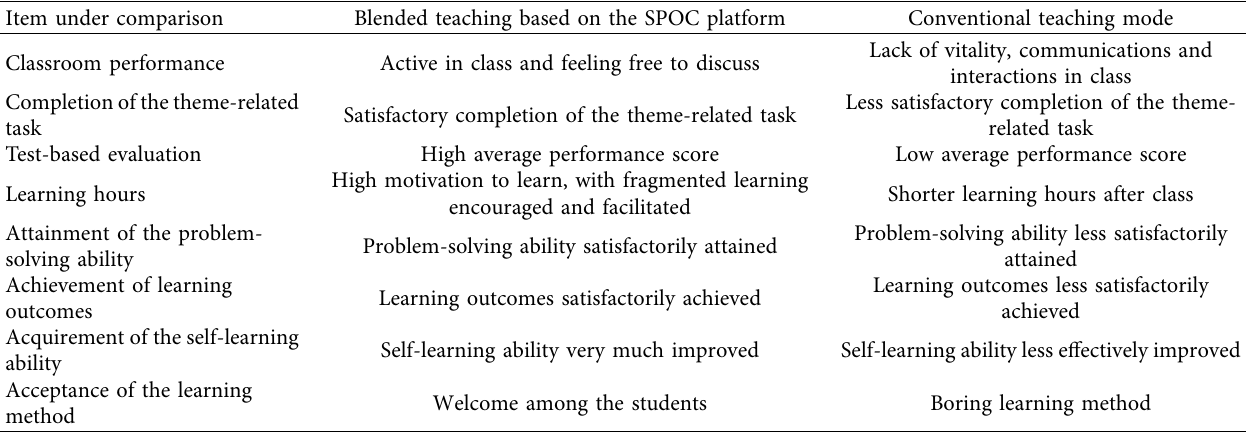
Table 4: Comparison of the SPOC-based teaching mode and the conventional teaching